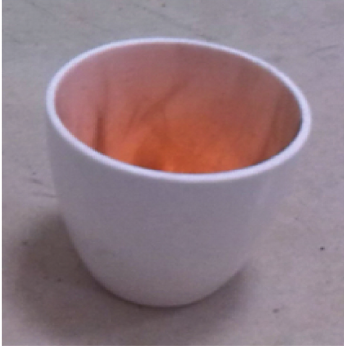
Fig. 2: Precursor in self-combustion at 300 ~ 400